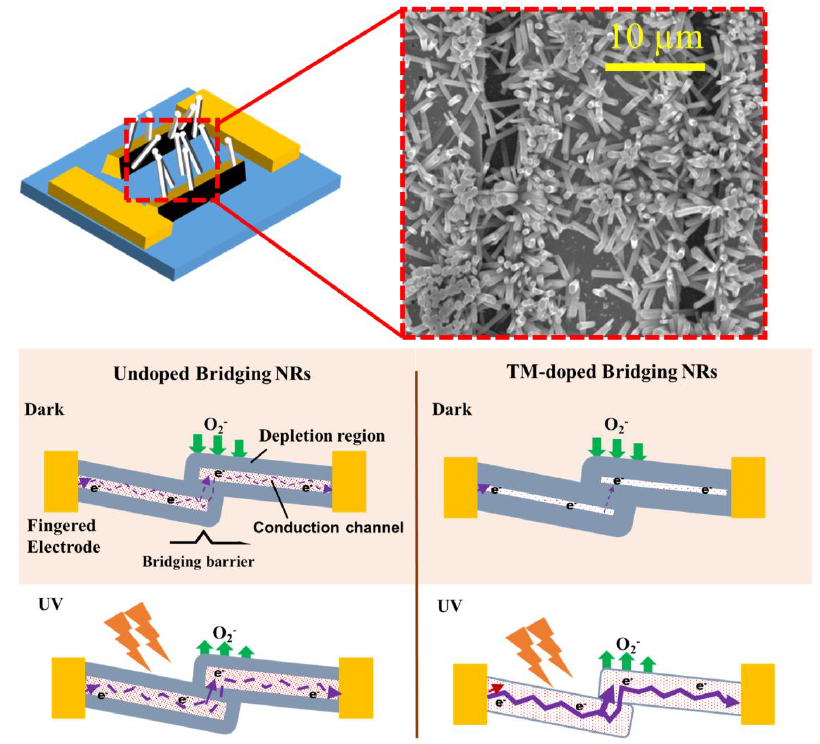
Figure 6. (Top) Schematic illustration of bridging NR structures formed between patterned electrodes and their SEM image shown in the right. (Bottom) Carrier generation and transportation in the ZnO bridging NRs (Left: undoped, Right: transition metal (TM)-doped).